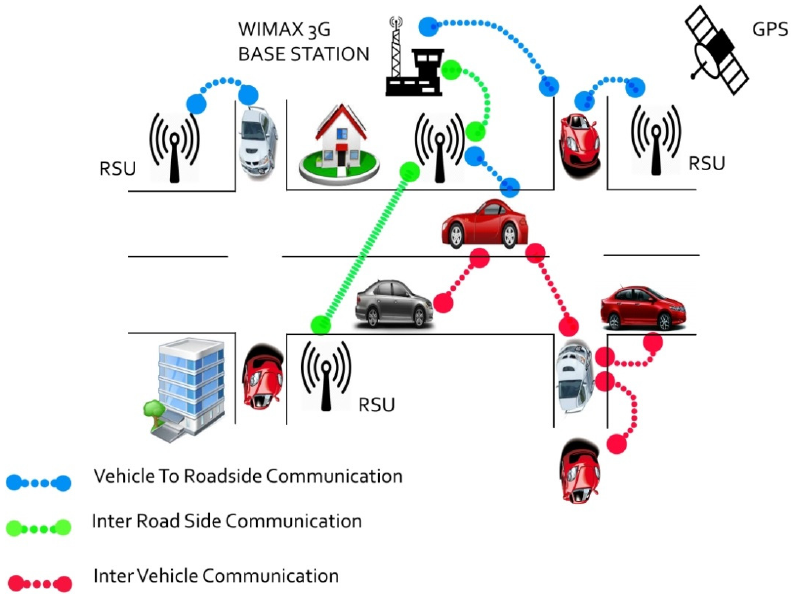
Figure 8. Architecture of the vehicular ad-hoc networks.